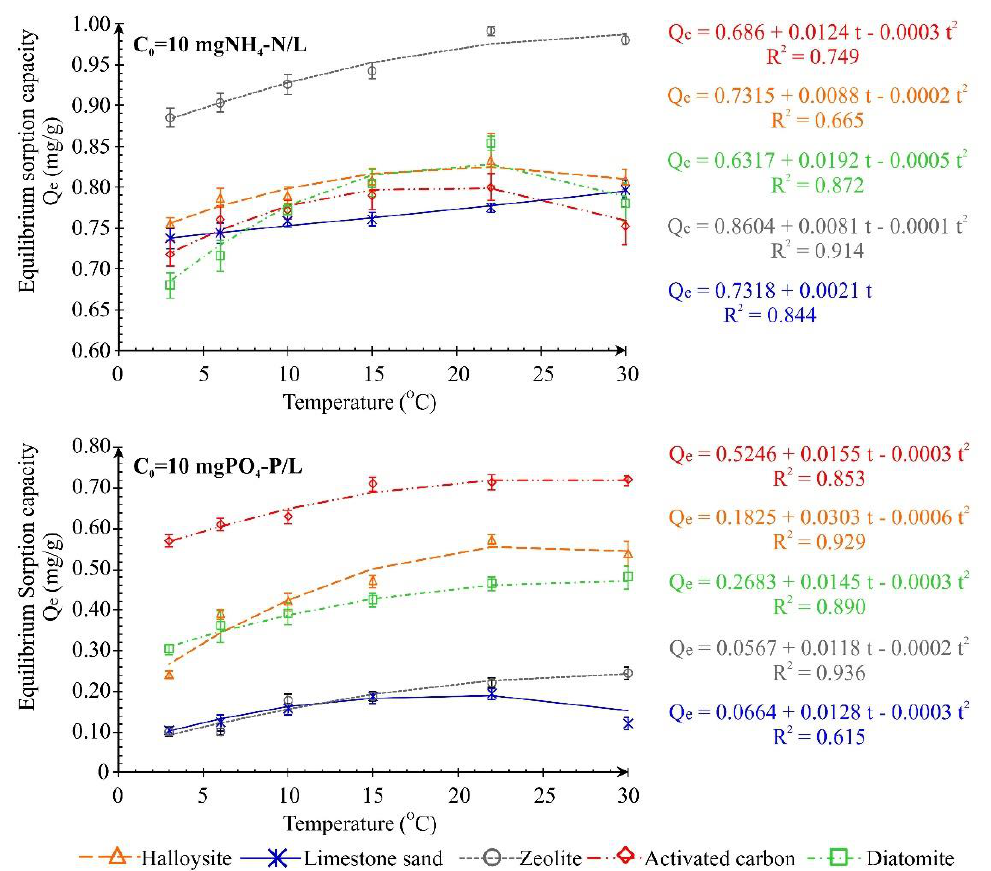
Figure 7. Impact of temperature on the efficiency of NH 4 -N and PO 4 -P removal with equations describing the relationship at initial concentrations of 10 mg/L (error bars mark the standard deviation, dashed line is the theoretical curve).